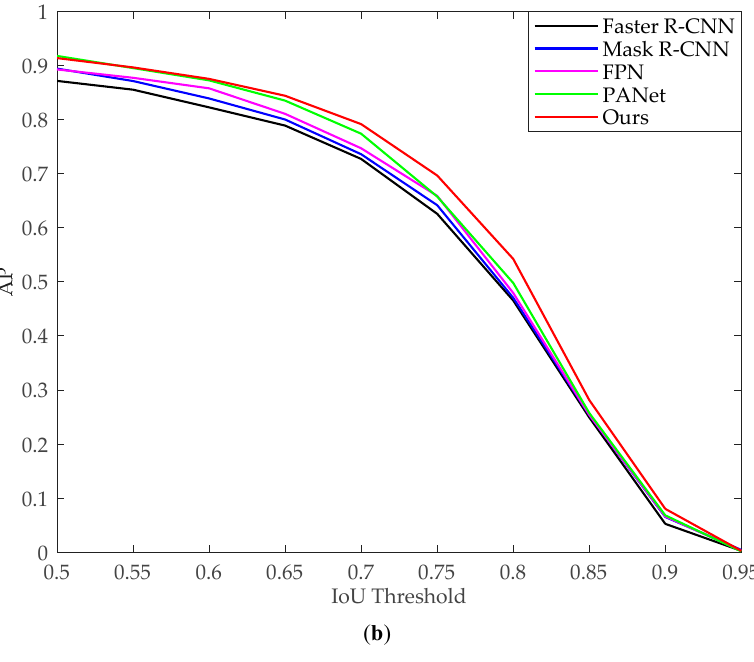
Figure 7. Comparison with four state-of-the-art methods on NWPU VHR-10 dataset in terms of curves of AP with di ff erent GIoU (IoU) thresholds. ( a ) GIoU threshold; ( b ) IoU threshold.